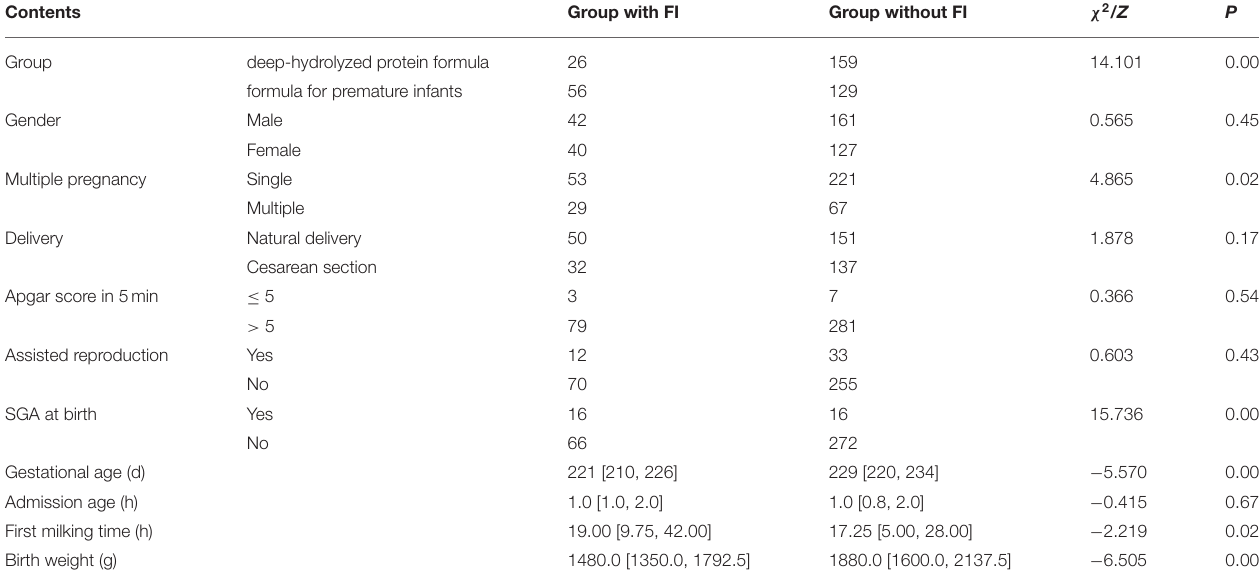
TABLE 3 | Indicators of possible influencing factors for FI.